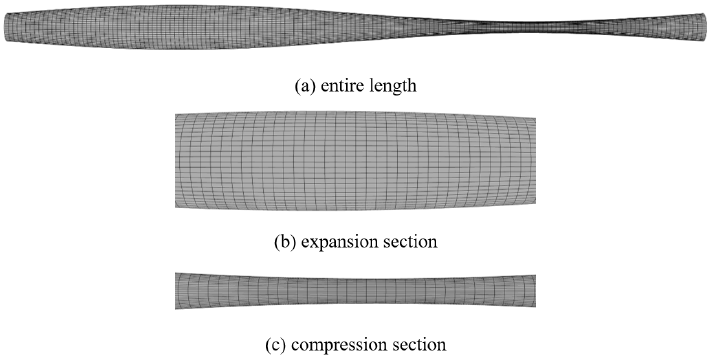
Figure 6. Computational mesh for the deformed tube in the transverse direction.